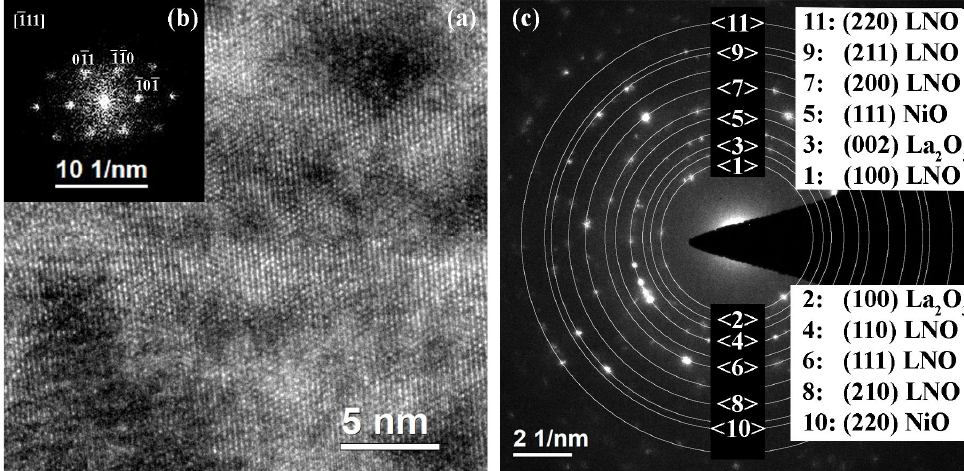
Figure 7. HRTEM image ( a ), corresponding Fourier diffractogram ( b ) and SAED pattern ( c ) of LNO-cryst-7 min sample.